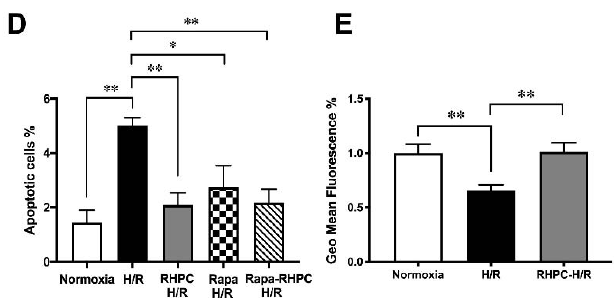
Figure 3. E ff ect of autophagy modulation on cell viability. ( A ) H9c2 cells were stained with calcein AM (green) and ethidium homodimer-1 (red). Green: live cells, Red: dead cells; the scale bar is 1000 µ m. Quantitative analysis of percentage of live / dead cells expressed as mean ± SEM, ( B ) Western blot analysis of pro-apoptotic Bax protein expression are expressed as mean ± SEM, fold relative to the normoxic control, ( C , D ) Cell apoptosis assessed by fluorescein isothiocyanate (FITC)-labeled annexin V (annexin V-FITC) and propidium iodide (PI) double staining and fluorescence-activated cell sorting (FACS). Quantitative analysis of percentage of apoptotic cells (annexin-V +/ PI + ) cells are represented as mean ± SEM; ( E ) Mitochondrial membrane potential at 1 h post-reoxygenation